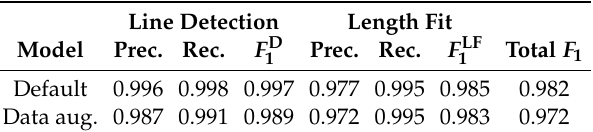
Table 2. Staff line detection and length metrics with and without data augmentation. The last column combines the two individual F 1 measures by